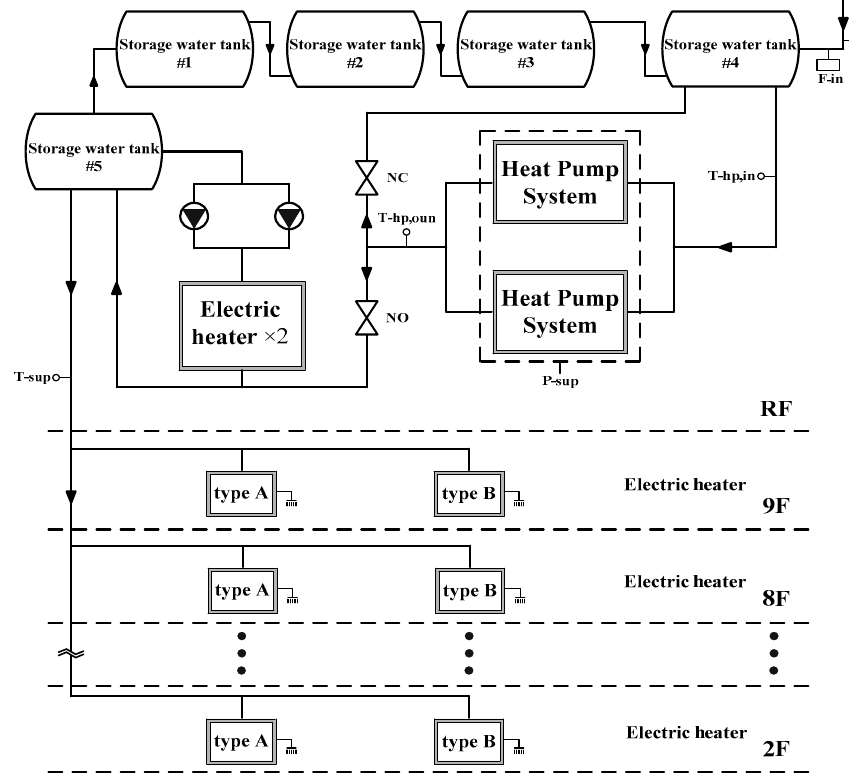
Figure 1. Schematic diagram of the investigated water heating system.